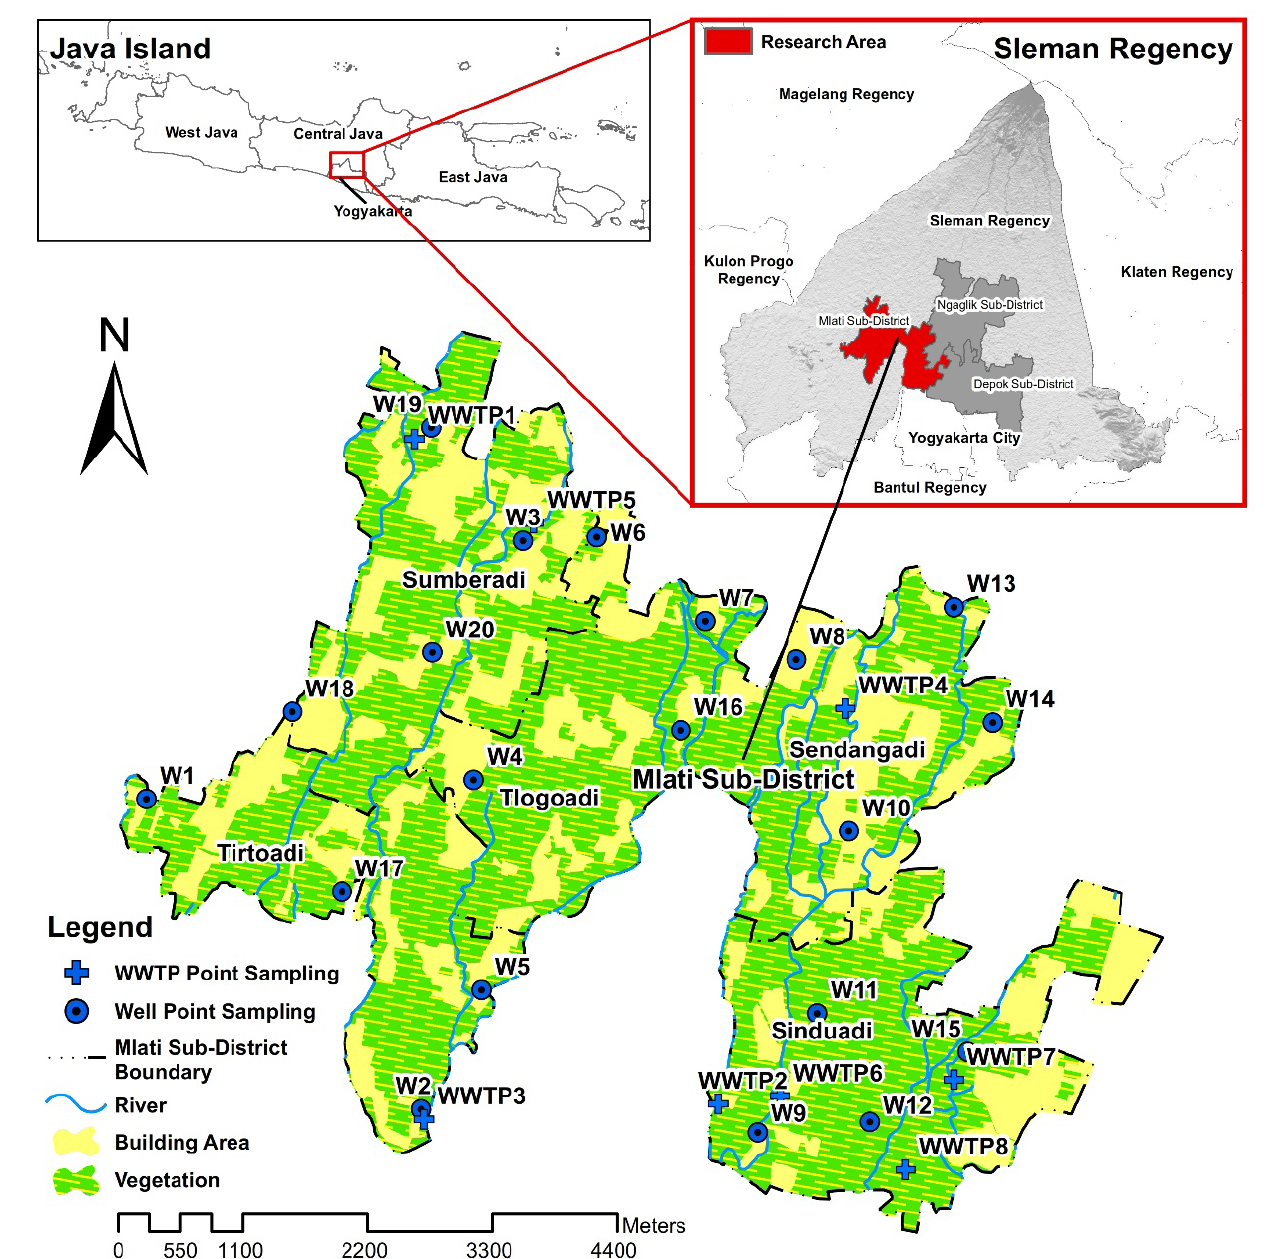
Figure 1. Study area and sampling location.